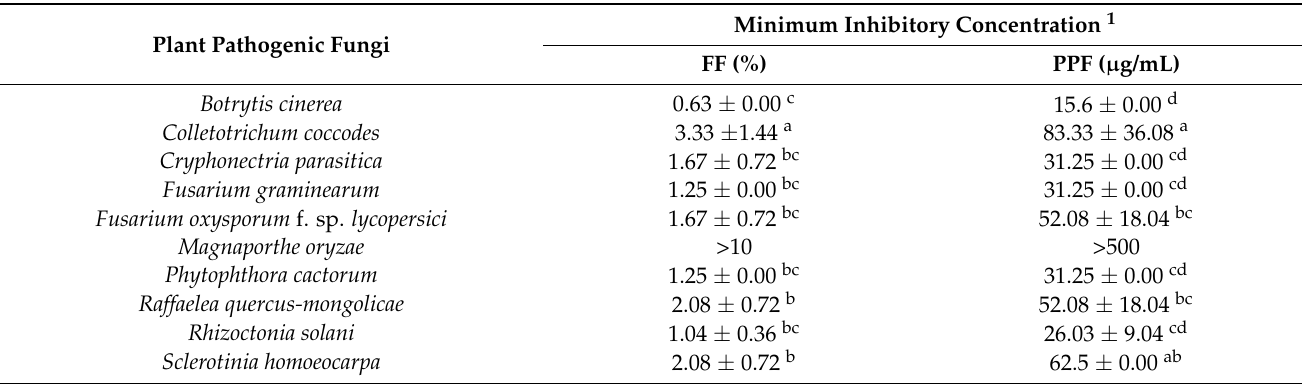
Table 2. In vitro assay of antifungal activity of the fermentation filtrate (FF) and the partially